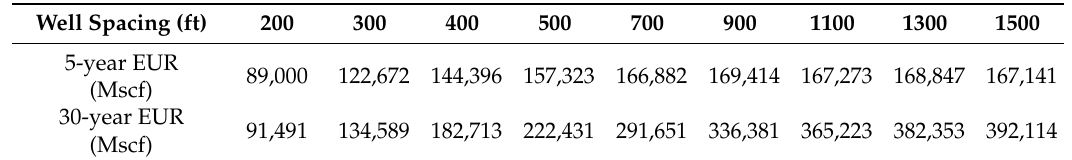
Table 3. Variation of 5-year and 30-year EURs (Mscf) when producing with well spacing varying between 200 and 1500 ft, as forecasted by the ResFrac integrated